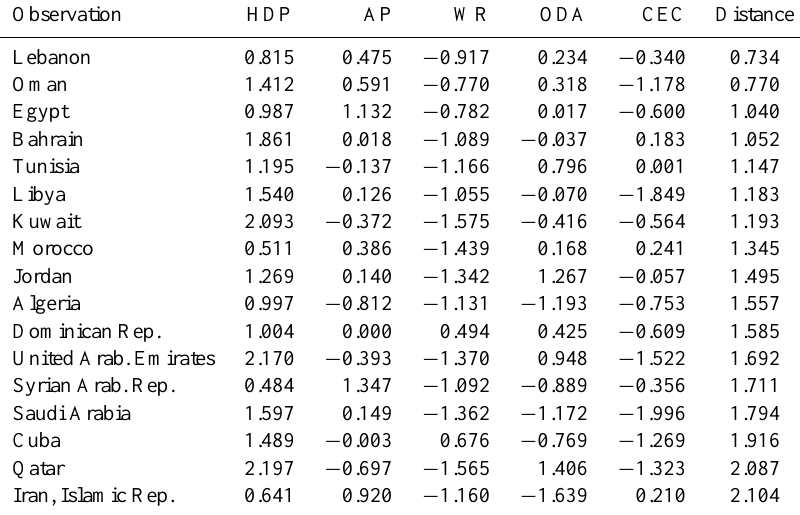
Table 8. Factors loadings and distances to the centroid of the profile